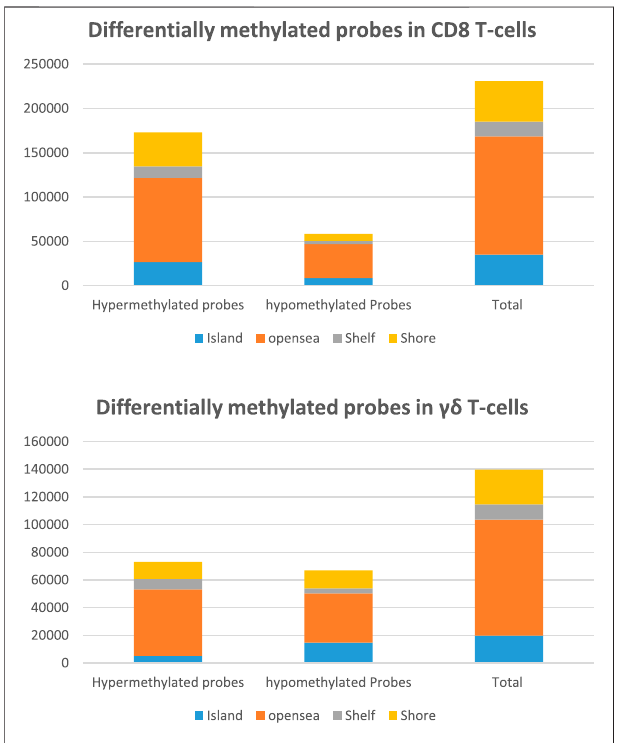
FIGURE 1 | Differentially methylated CpG sites in CD8 T cells and γδ T cells with p-values < 0.05.